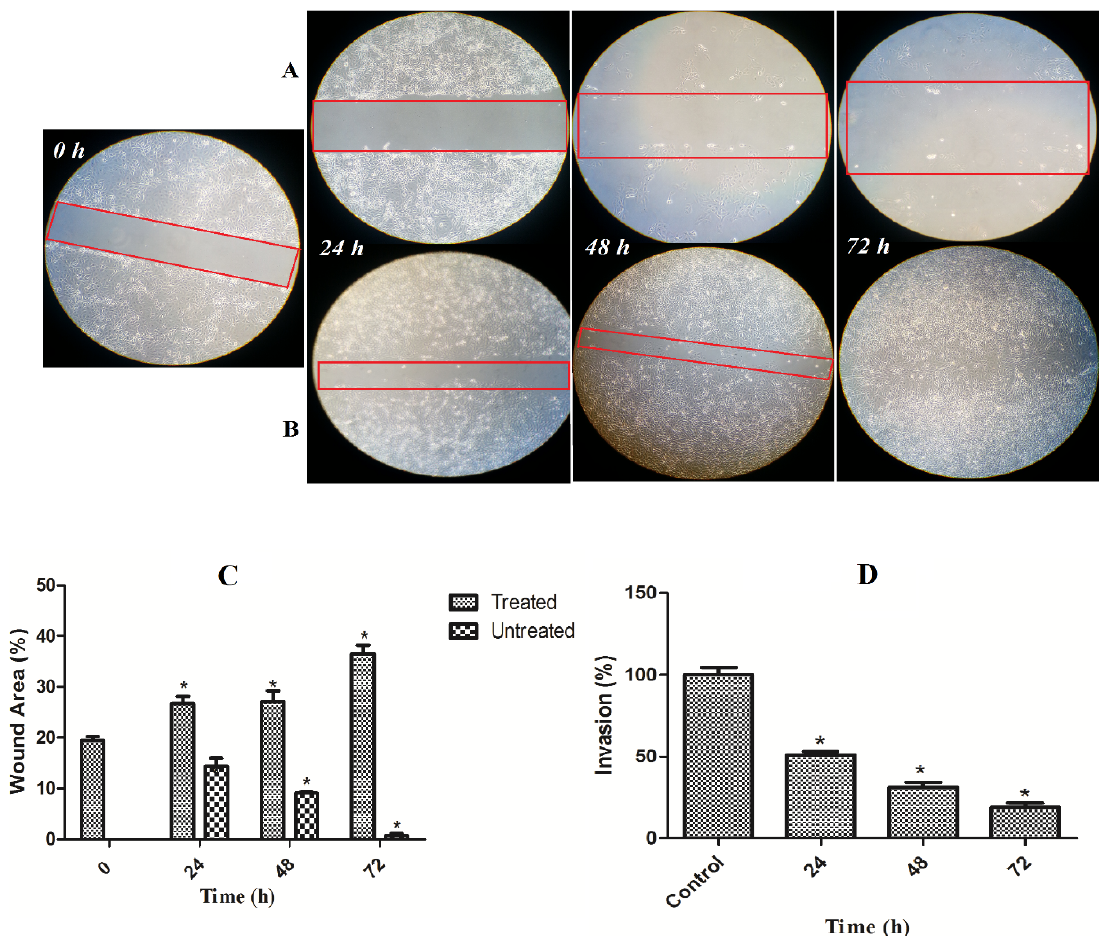
Figure 14. TPHE blocked MCF7 cell migration and invasion. ( A ) TPHE suppressed breast cancer cell migration. MCF7 cells were seeded in 6-well plates. The confluence MCF7 cells were wounded and imaged (0 h). After treatment of MCF7 cells with TPHE at IC concentration, cells were incubated at 37 °C for 24, 48 and 72 h and photographed. ( B ) The untreated cells of MCF7 were significantly migrated within 72 h. ( C ) The quantitative analysis of images revealed the significant suppressive effect of TPHE against MCF7 migration. ( D ) TPHE significantly suppressed MCF7 cell invasion. Percentage of invasion was determined as the percent of MCF7 cells invaded through Matrigel inserts vs . the total MCF7 cells invaded through the control inserts. The data are shown as the mean ± SD ( n = 3). * represents significant difference ( p < 0.05) compared with the